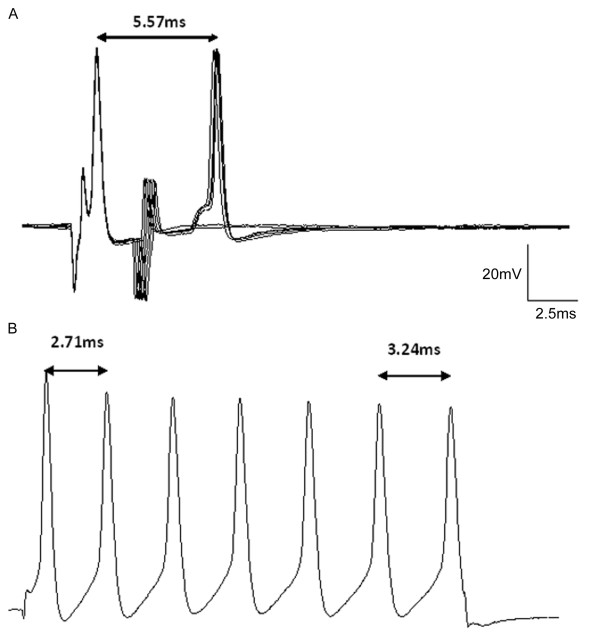
Comparison of APs evoked by dorsal root paired-pulse stimulation and by soma current injection. The figure shows APs in one specific MS in a neuropathic animal evoked by dorsal root paired pulse stimulation and by soma current injection. A. shows a delayed second response by 2.6~ 2.9 ms at intervals of paired dorsal root stimulation and a failed response at 2.5, 2.6 ms. The actual delayed response interval was at least 5.57 ms. B. shows 7 APs in response to depolarizing current injection, with individual AP intervals of 2.71~3.24 ms.